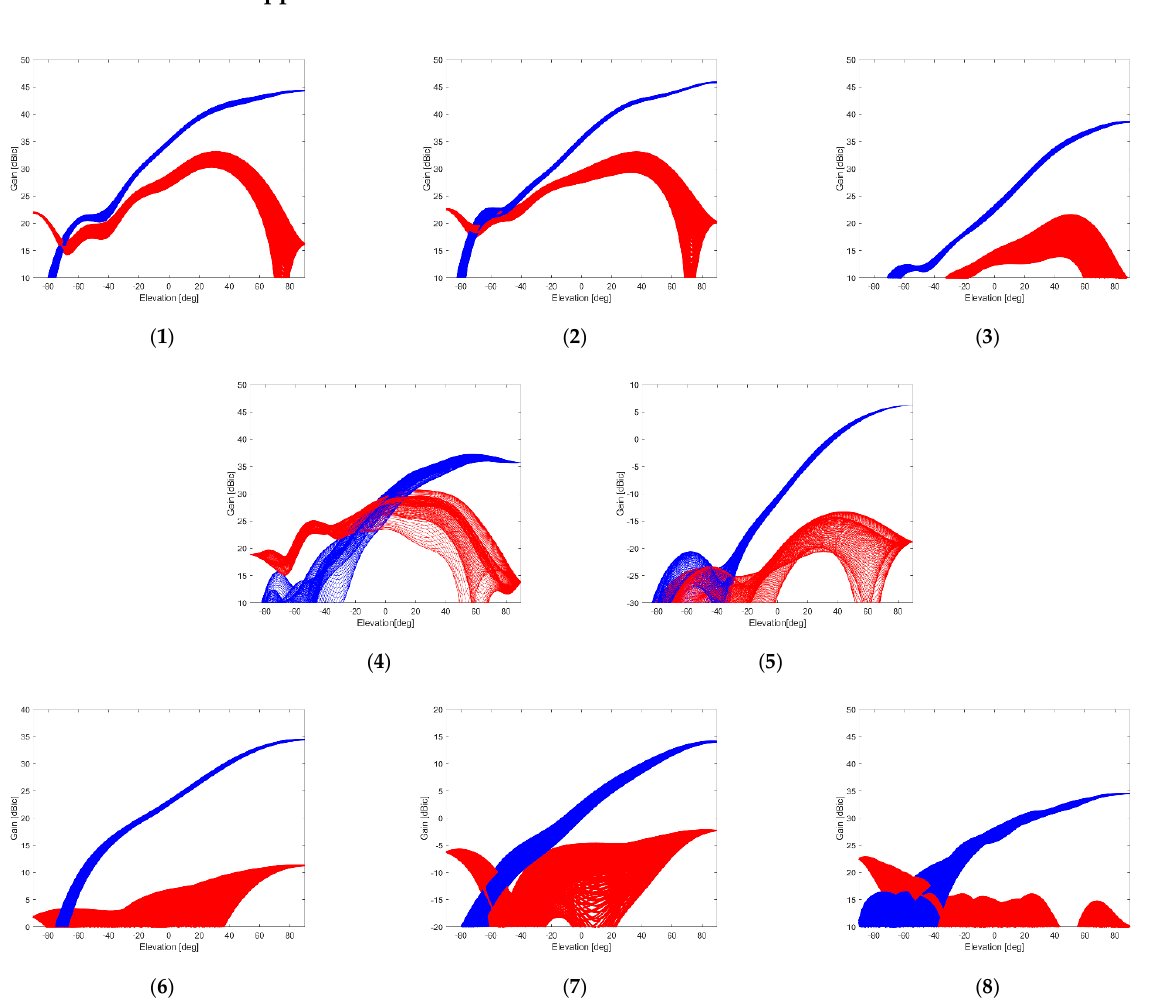
Figure A1. Gain in dBic (RHCP in blue, LHCP in red; different lines represent different azimuth values with a resolution of 2 deg) at L1/E1 central frequency of the antennas measured at DLR; from left to right, from top to bottom: ( 1 ) Leica AR25 R4, ( 2 ) Novatel GNSS-750, ( 3 ) Javad RingAnt-DM; ( 4 ) Space Engineering GalExpAnt; ( 5 ) DLR internal design; ( 6 ) Novatel 703-GGG; ( 7 ) NavXperience Nav3G+C; ( 8 ) Tallysmann VSE6028 VeroStar. The plots for the different antennas exhibit always a gain range of 40 dB along the y -axis, though having different maximum gain values. This is due to the fact that some antennas are passive and some are active with different LNA gains.